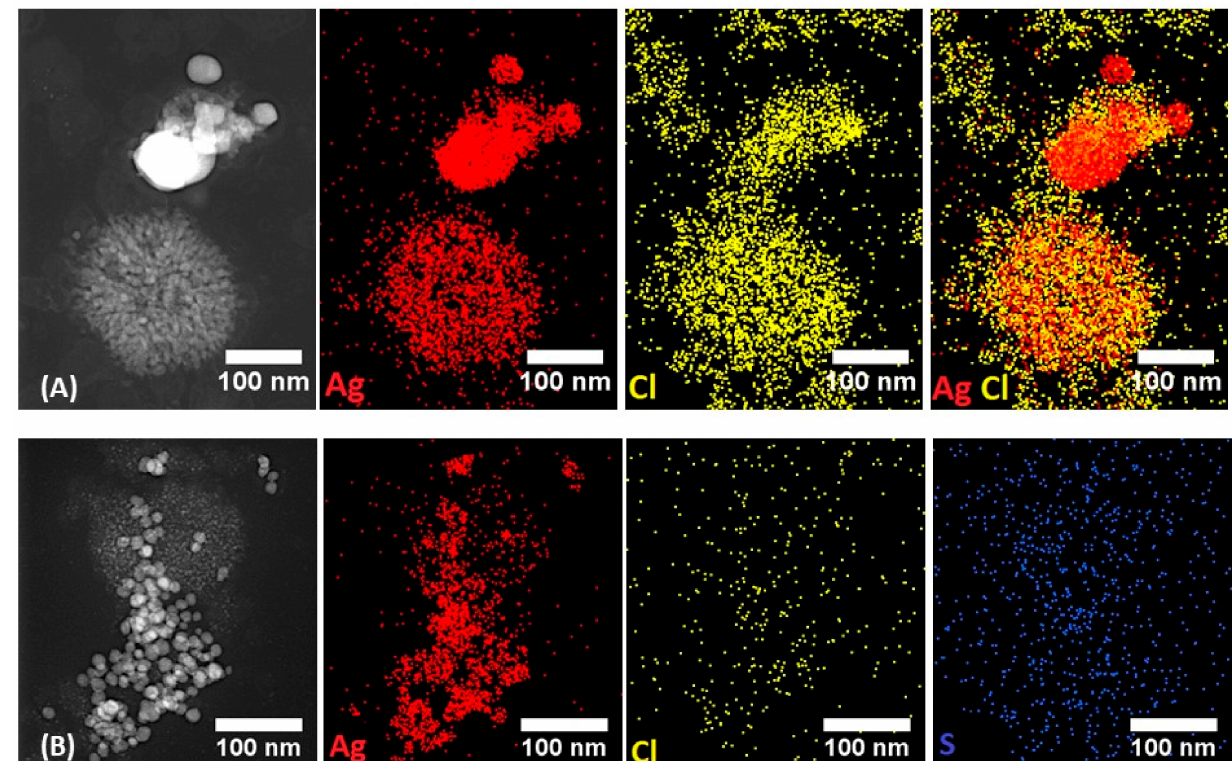
Figure 2. ( A ) Energy-dispersive spectroscopy (EDS) mapping of the stomach digested NPs showing few metallic AgNPs on the upper part of the image (the Cl map confirm, especially in the overlay image, that the Cl in that area probably comes from the stomach matrix but not from the NPs) and a dendritic structure comparable to the one previously shown in the TEM-SAED characterization, which appears to be AgCl; ( B ) EDS mapping of the intestine digested NPs. In this case, no localization of the Cl in the proximity of the NPs has been found. In order to exclude the possible presence of silver sulphide nanocrystals, S map is presented without any co-localization with the